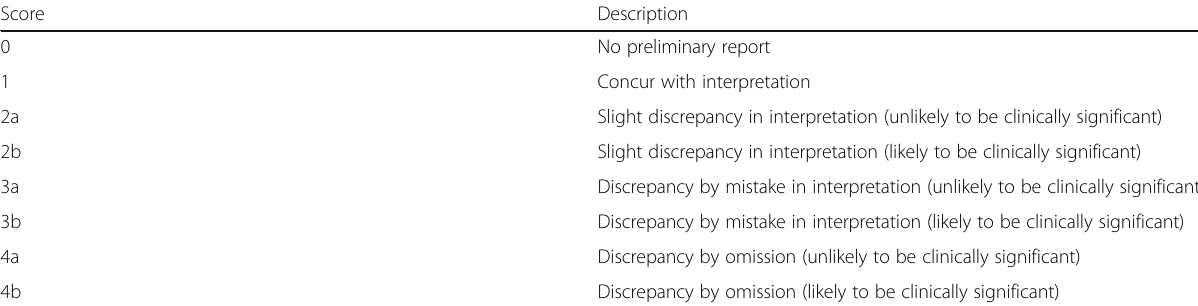
Table 1 Evaluation score for radiology residents Score